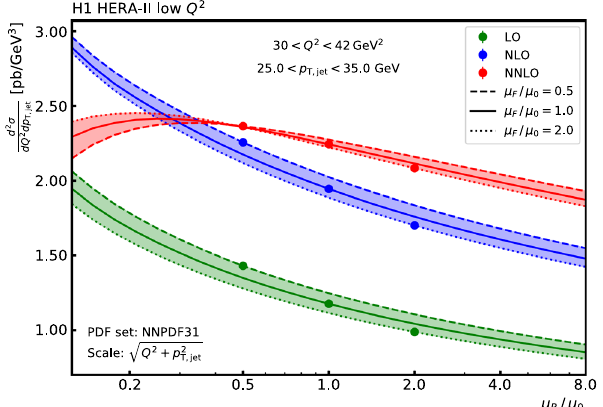
the result of varying the factorisation scale μ F by factors between 0.5 and 2.0 with respect to the nominal scale. At each order three points indicate the result of symmetric variations of μ R and μ